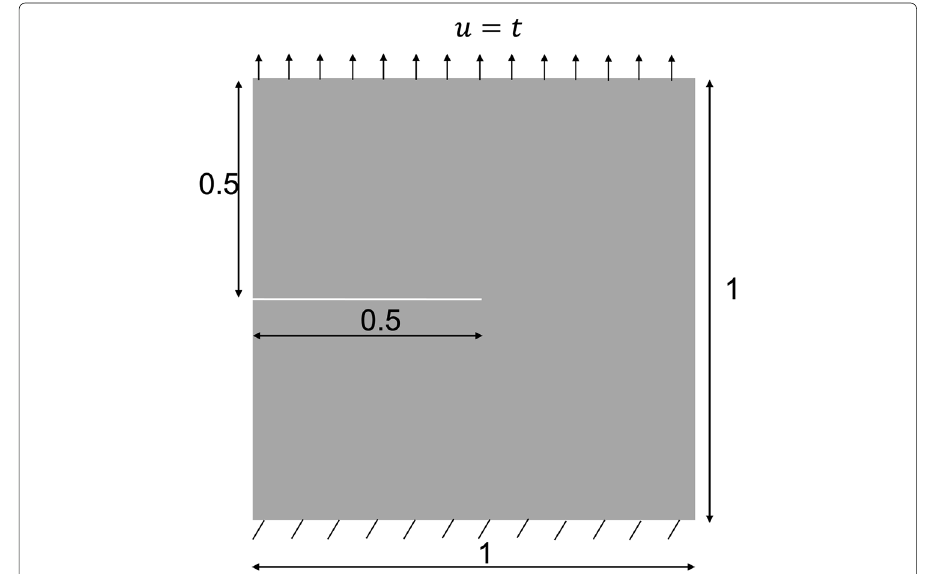
Fig. 5 Geometry and boundary conditions for the SENT simulation. A positive y -displacement is applied across the top boundary and the x - and y - displacements are fixed on the bottom boundary